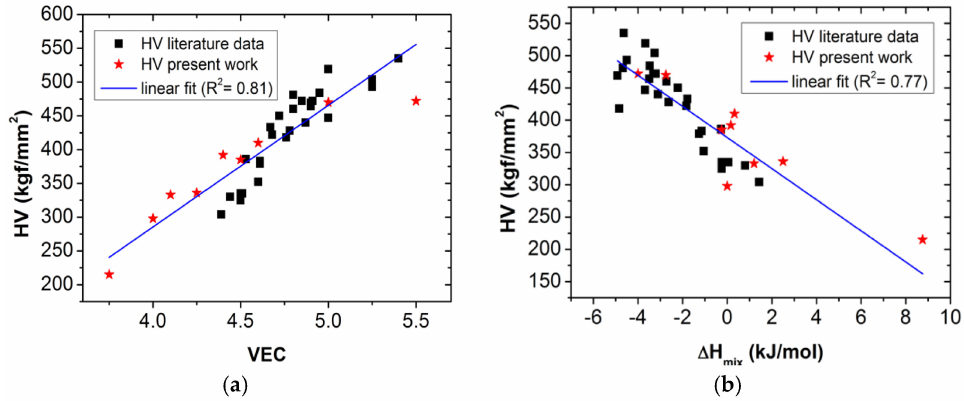
Figure 5. HV , in the function of VEC ( a ); and of ∆ H mix ( b ) for the various ETM-based RHEA samples listed in Table